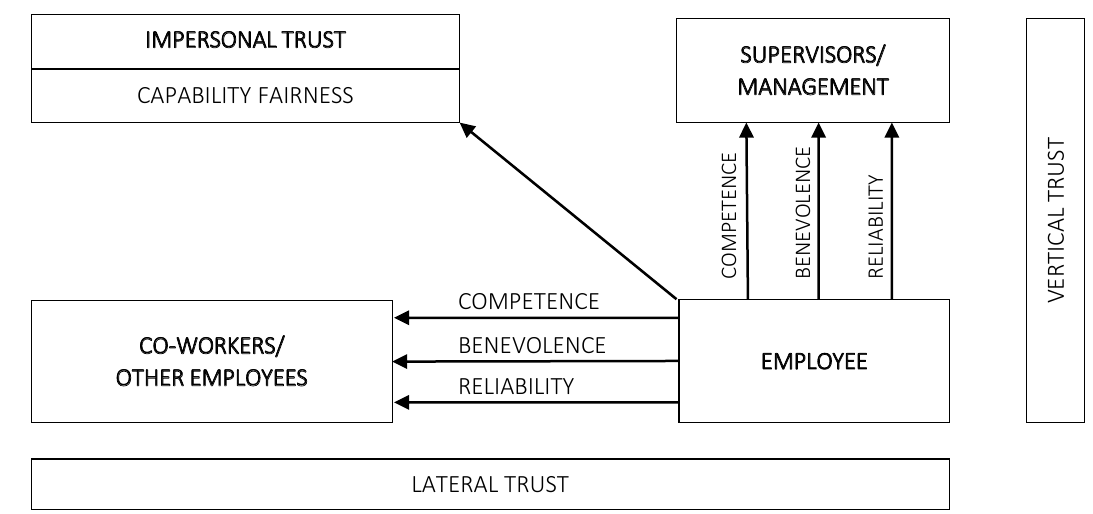
Figure 1. The stucture of organizational